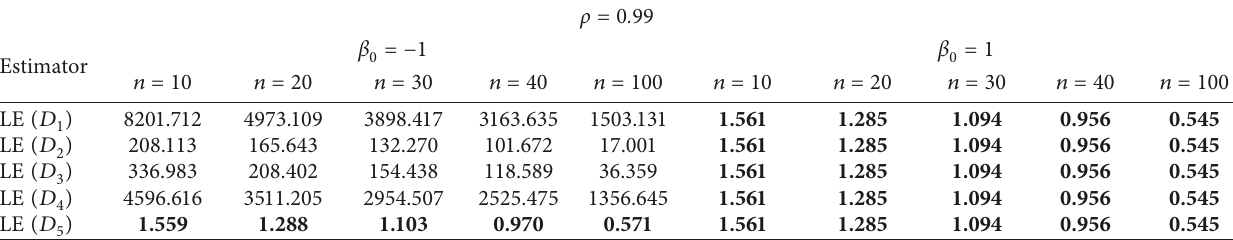
when δ � 0 . 04 , α � 0 . 03 , and p � 2. 0 ρ � 0 .